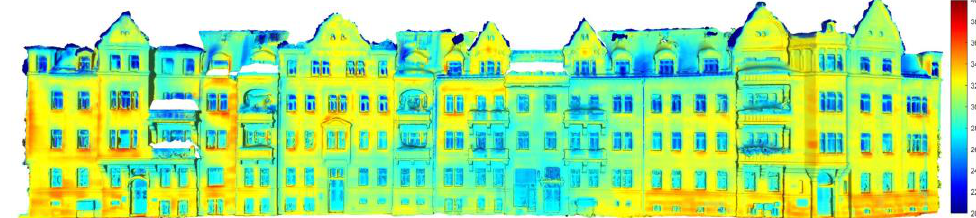
Figure 1. Projection of a 3D point cloud of a façade with thermal attributes (°C) (Lin et al.,